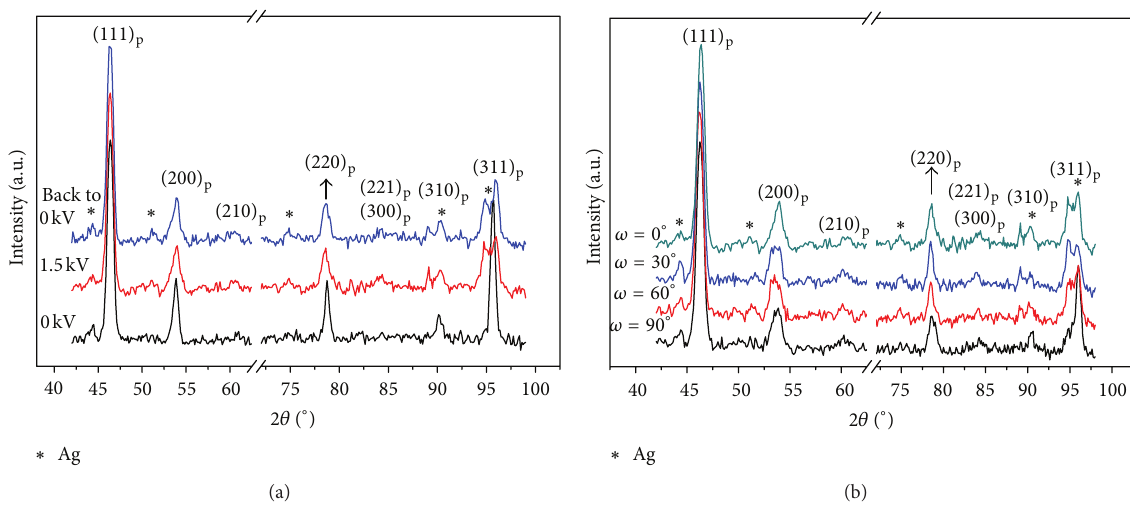
Figure 1: Neutron diffraction patterns of BNTBT7 collected at room temperature (a) under different applied electric fields and at 𝜔 = 0 ∘ and (b) under 1.5kV and at different 𝜔